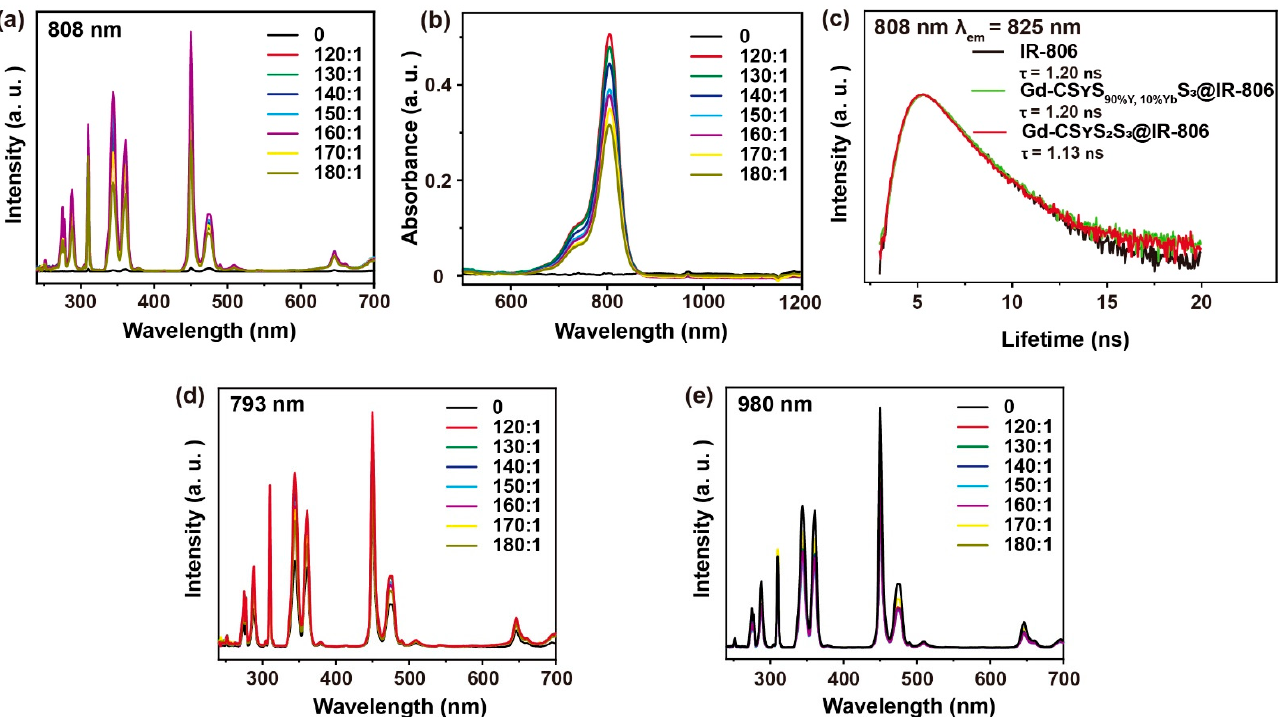
Figure 3. Optimizing the weight ratio of Gd-CS Y S 2 S 3 to IR-806 and calculating the energy transfer efficiency. ( a ) The emission spectrum of Gd-CS Y S 2 S 3 (4 mL in CHCl 3 , 0.375 mg/mL) after adding various masses of IR-806 dye under 808 nm excitation. ( b ) The absorption spectrum of Gd-CS Y S 2 S 3 (4 mL in CHCl 3 , 0.375 mg/mL) with various masses IR-806 dye. ( c ) The decay curves of Gd-CS Y S 2 S 3 , Gd-CS Y S 2(90%, 10%Yb) S 3 @IR-806, and Gd-CS Y S 2 S 3 @IR-806. ( d , e ) The emission spectra of Gd-CS Y S 2 S 3 (4 mL in CHCl 3 , 0.375 mg/mL) after adding various masses of IR-806 dye under 793 nm and 980 nm excitation, respectively.